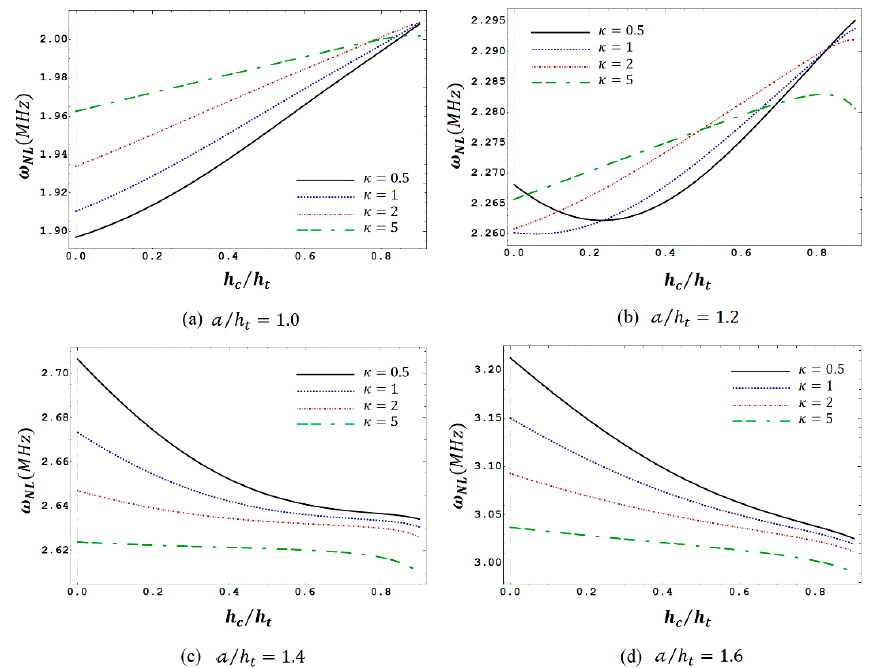
Figure 9. Variation of the first-order nonlinear frequency of a GPL-reinforced sandwich beam with respect to an increasing core-to-face thickness ratio for different power-law parameters and amplitudes of vibration ( N = 10, Γ b = 1%, L / h t = 10).